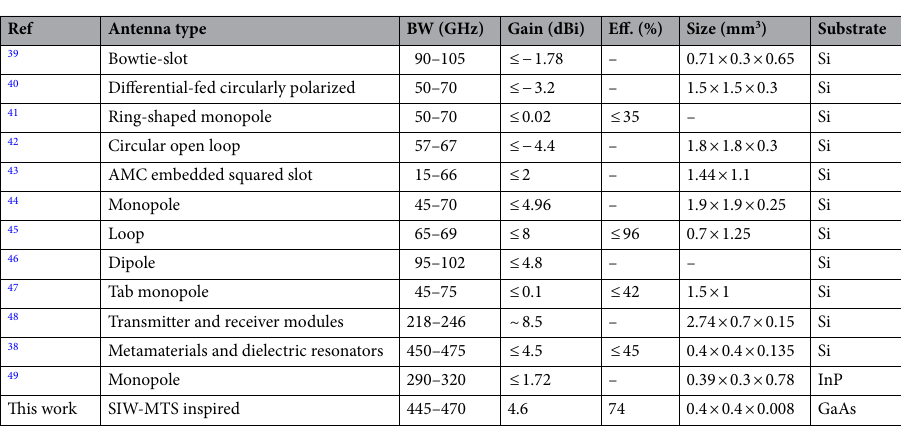
Table 5. Proposed AoC compared with state-of-the-art